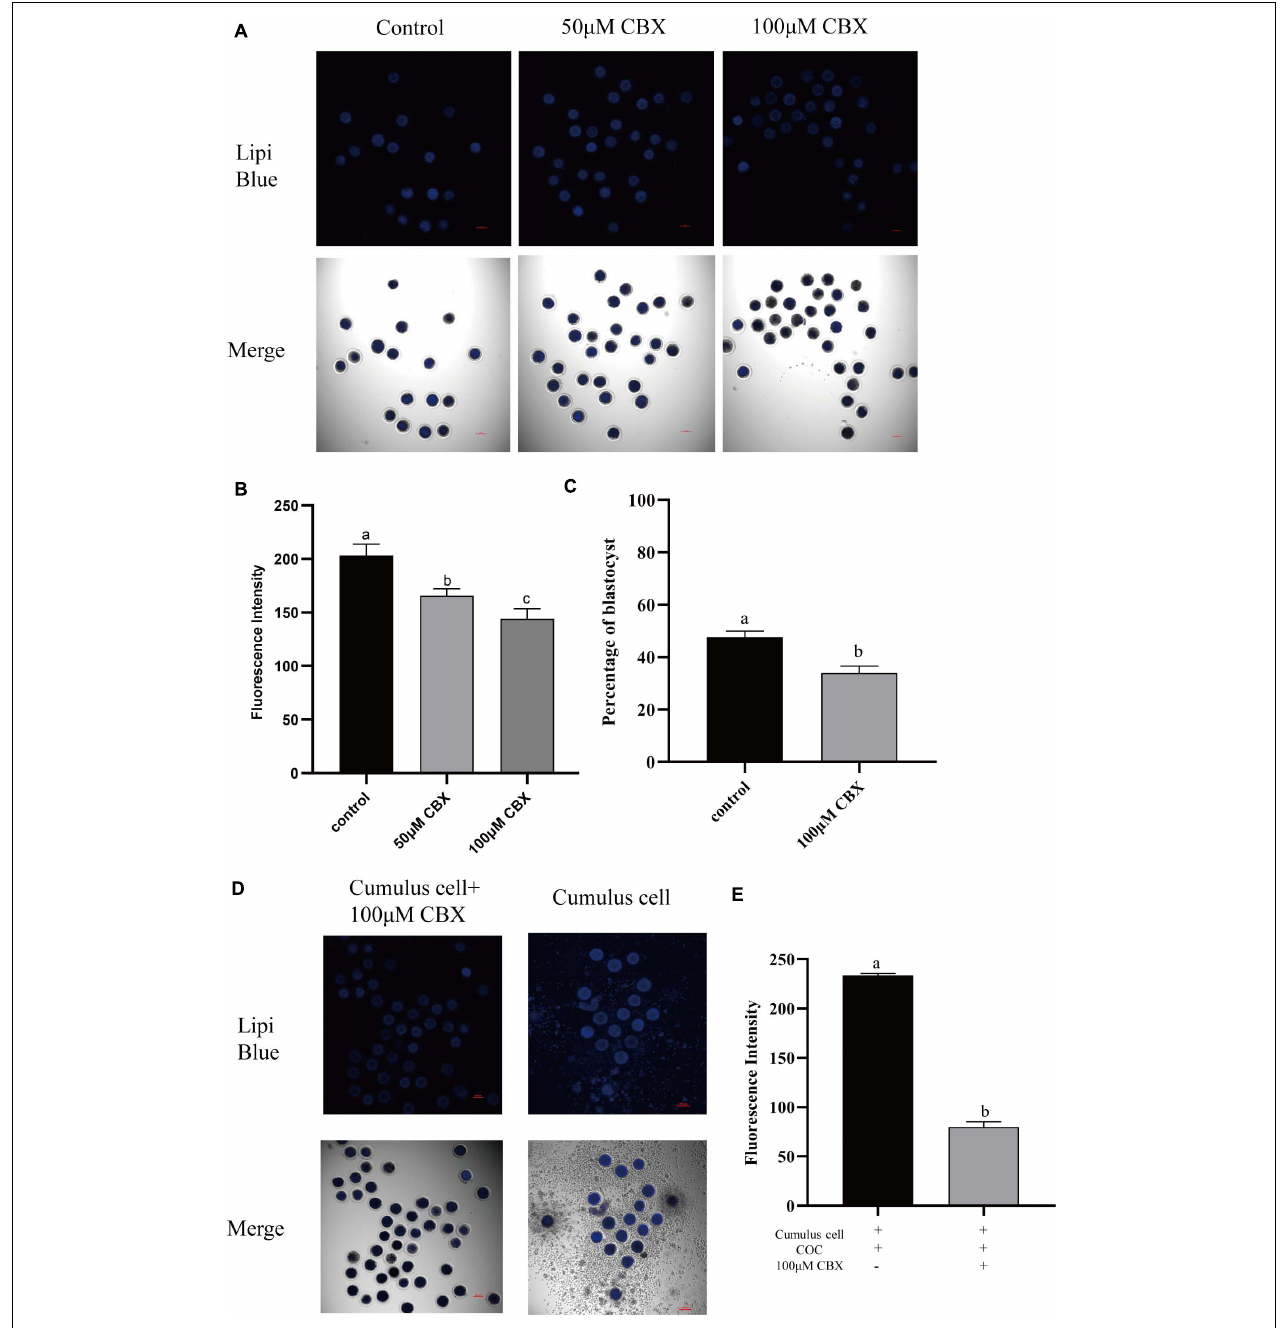
FIGURE 4 | Cumulus cells participate in the regulation of lipid metabolism in porcine oocytes. (A) Representative images of Lipi-Blue fluorescence (blue) in porcine oocytes treated with 50 and 100 µ M CBX. Scale bar: 100 µ m. (B) Quantification of fluorescence intensity of Lipi-Blue in porcine oocytes treated with control ( n = 29), 50 µ M CBX ( n = 28), and 100 µ M CBX ( n = 70). (C) The percentage of blastocysts in porcine oocytes treated with control ( n = 108) and 100 µ M CBX ( n = 44). (D) Representative images of Lipi-Blue fluorescence (blue) in porcine oocytes treated with 100 µ M CBX and granulosa cell–COC co-cultivation system. Scale bar: 100 µ m. (E) Quantification of fluorescence intensity of Lipi-Blue in porcine oocytes treated with 100 µ M CBX + GC ( n = 44) and GC ( n = 16). Student’s t -test and one-way ANOVA were utilized for statistical analyses. Different lowercase letters indicate significant differences. Error bars indicate SEM.